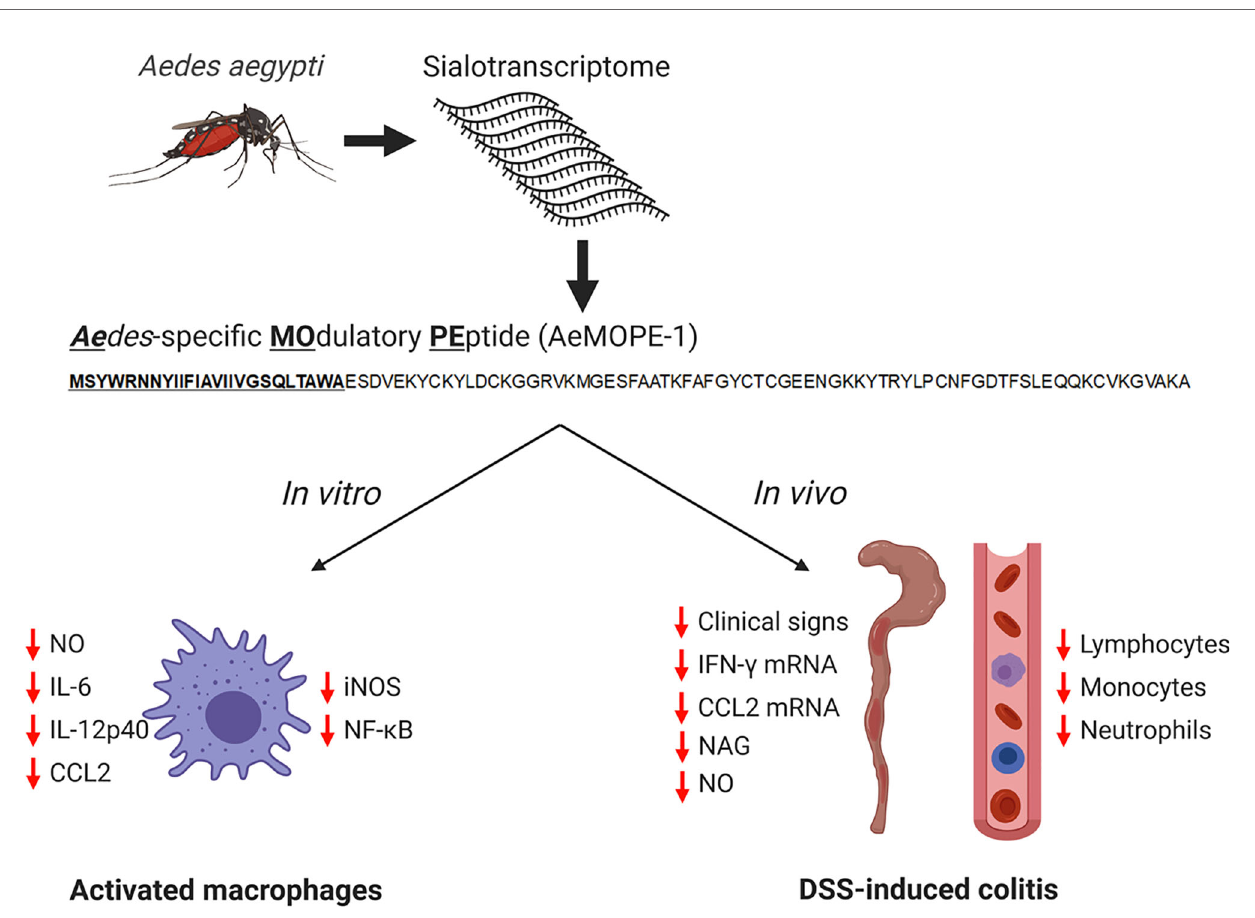
FIGURE 7 | Immunomodulatory activities of syn-AeMOPE-1 in vitro and in vivo . The AeMOPE-1 transcript was identi fi ed in Aedes aegypti sialotranscriptomes. The mature secreted form of the peptide was synthetized and evaluated in murine macrophage cultures and in DSS-induced colitis. The immunomodulatory activities of the peptide are depicted in the fi gure. (Created with